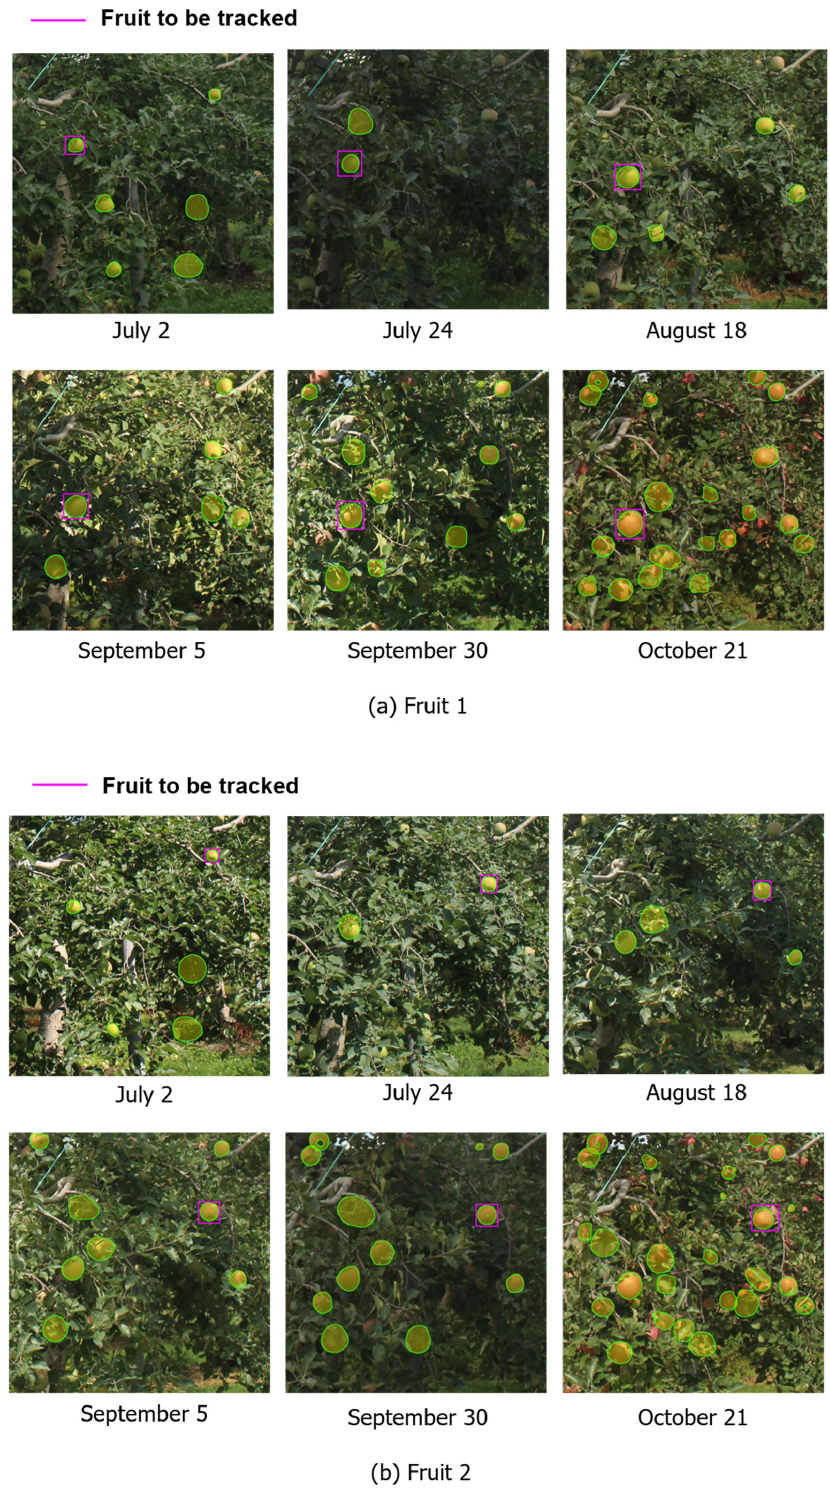
Figure 15. Examples of detections by the proposed model. Fruits detected are indicated by areas of green lines painted orange, and the fruit targeted for tracking are indicated by purple rectangles. Although there are some detection errors, the proposed method can detect individual fruits even when they are in contact with each other or densely packed together, as in the image from 21